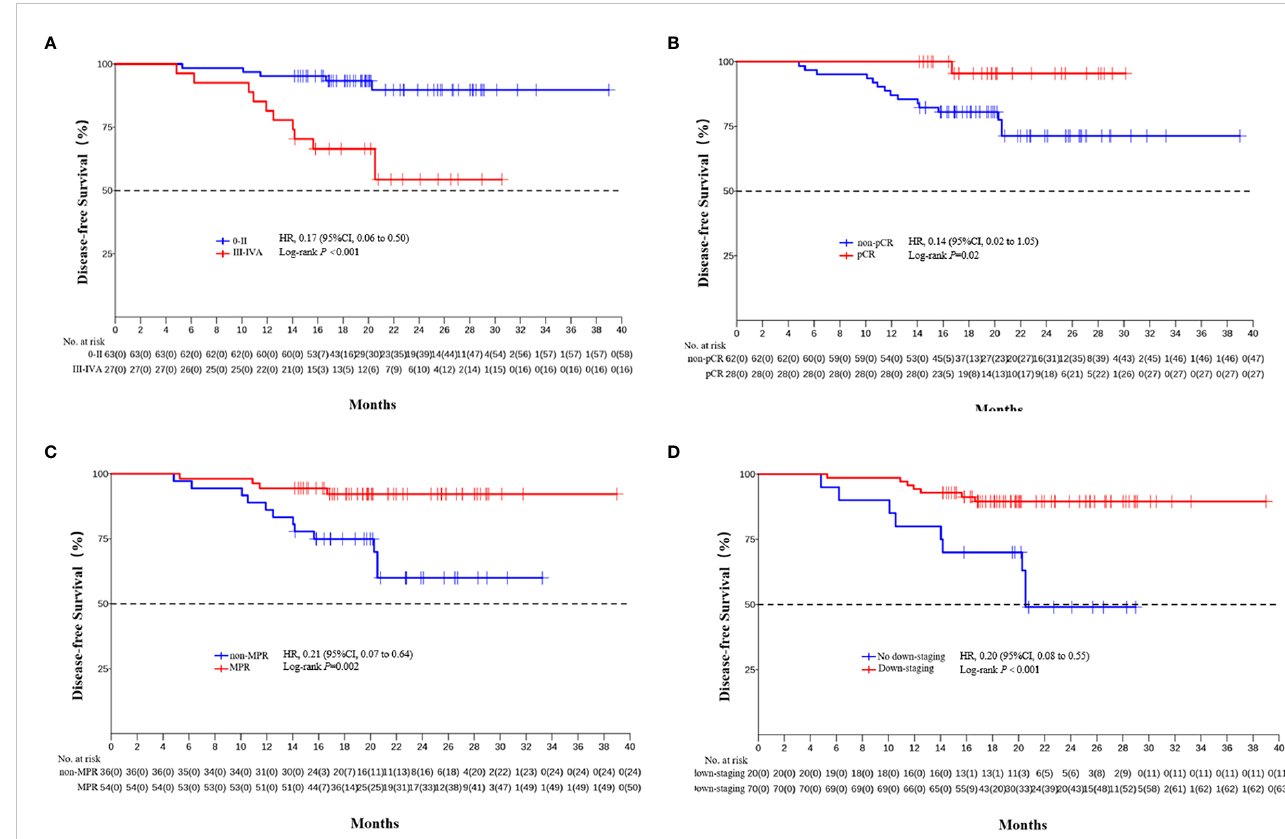
FIGURE 3 Kaplan-Meier estimates of DFS strati fi ed by pathological responses. (A) DFS of the pathological stage 0-II group and the III/IVA group. (B) DFS of the pCR group and the non-PCR group. (C) DFS of the MPR group and the non-MPR group. (D) DFS of the tumor pathological down-staging group and not achieving tumor pathological down-staging